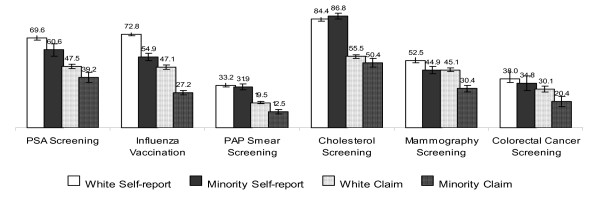
Unadjusted percent* of respondents, by minority status, with a self-report or claim for a preventive procedure. * Horizontal lines at the top each bar refer to 95% confidence intervals surrounding the estimate.